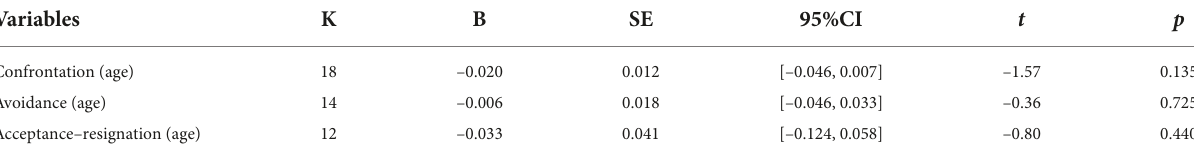
TABLE 4 Univariate regression analysis of year (random effects